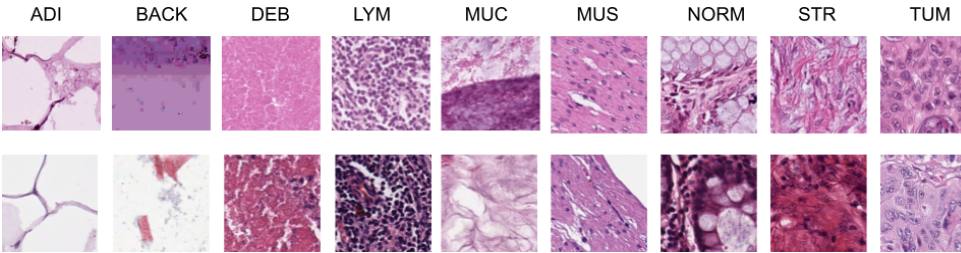
Figure 5. Example of 9 tissue classes in our dataset. The top row shows the images with Macenko filter. In the bottom row, no color normalization was applied to these